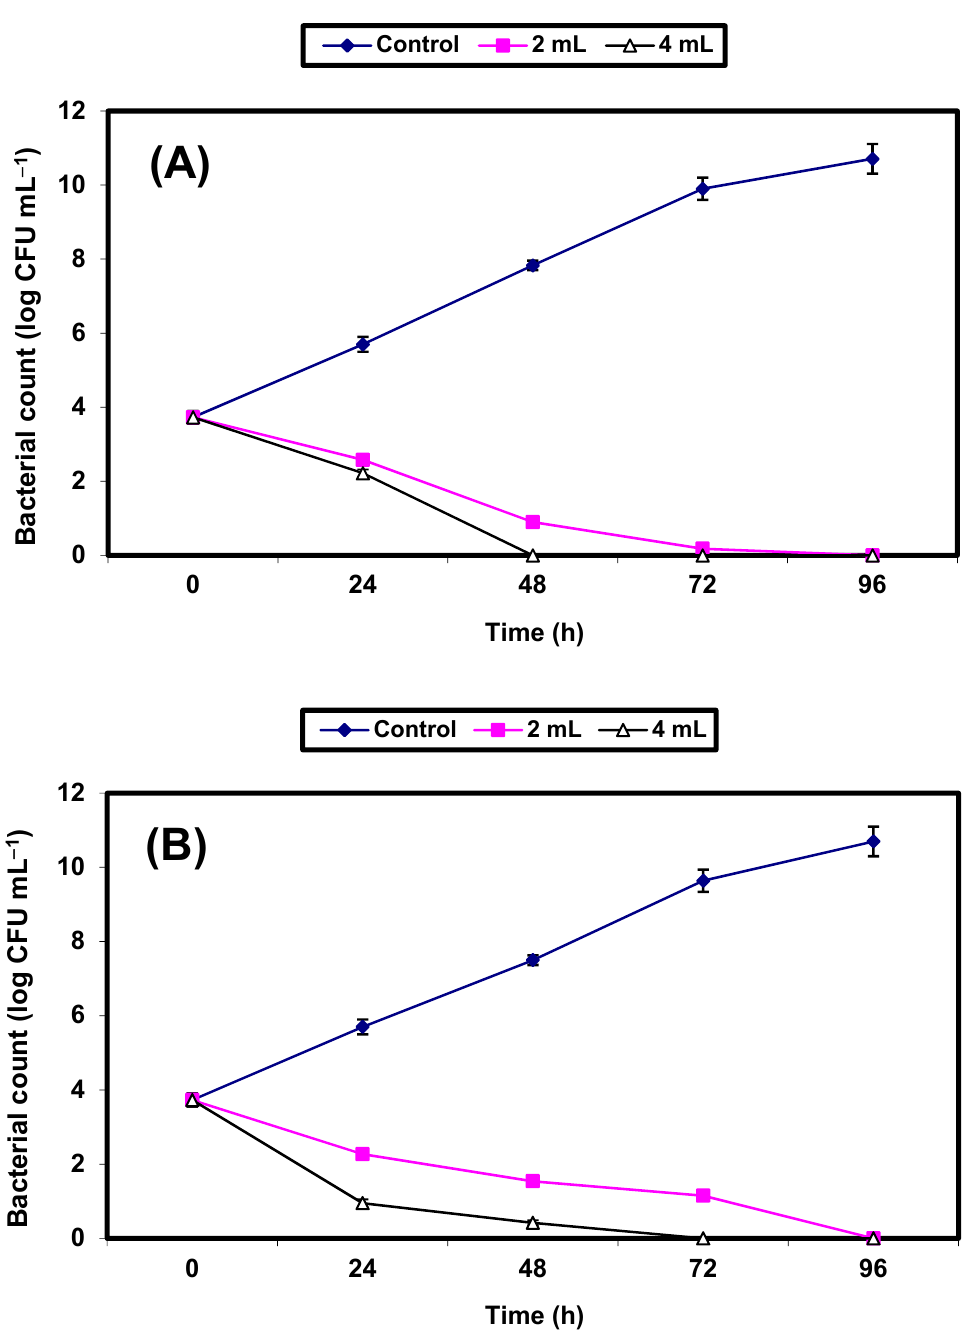
Figure 5. Inhibition of both S. aureus ( A ) and E. coli ( B ) in guava juice. Symbols ♦ , ■ , ∆ refer to untreated control samples and juice samples treated with 2% and 4% KFB, respectively.